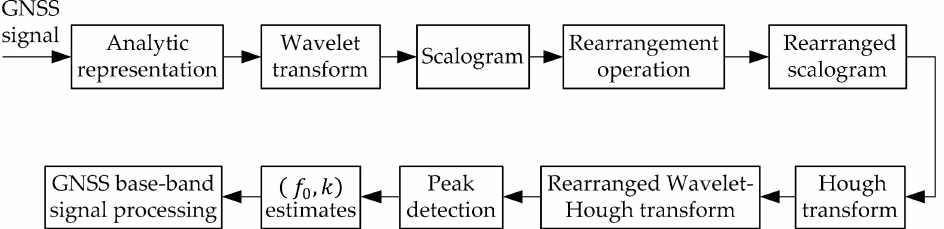
Figure 6. Interference detection by using the rearranged wavelet–Hough transform for GNSS receivers.